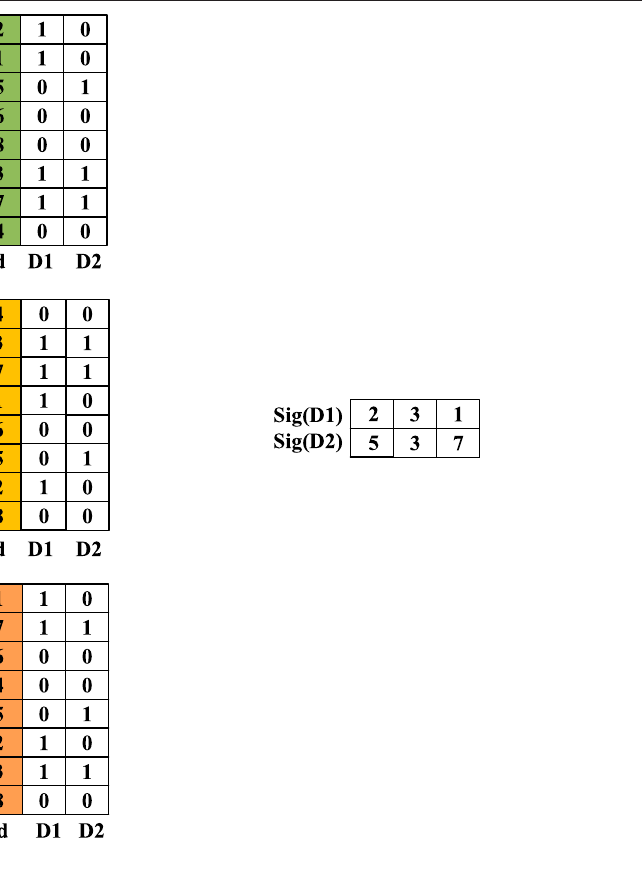
FIGURE 1 | Example of min hash